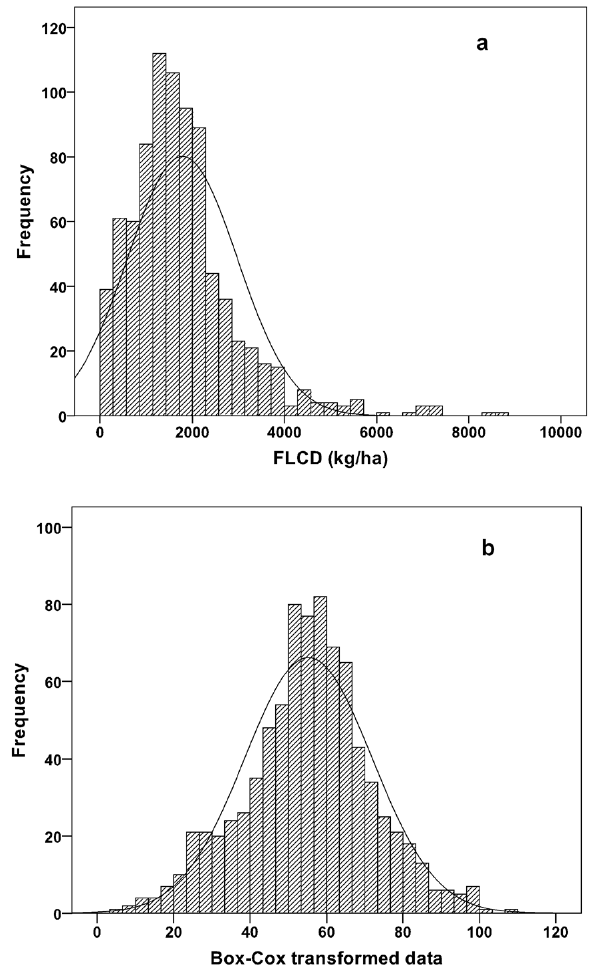
Fig. 3. Histograms of FLC density: (a) raw data and (b) Box–Cox transformed data. Fig. 3 Histograms of FLC density: (a) raw data; (b) Box-Cox transformed data